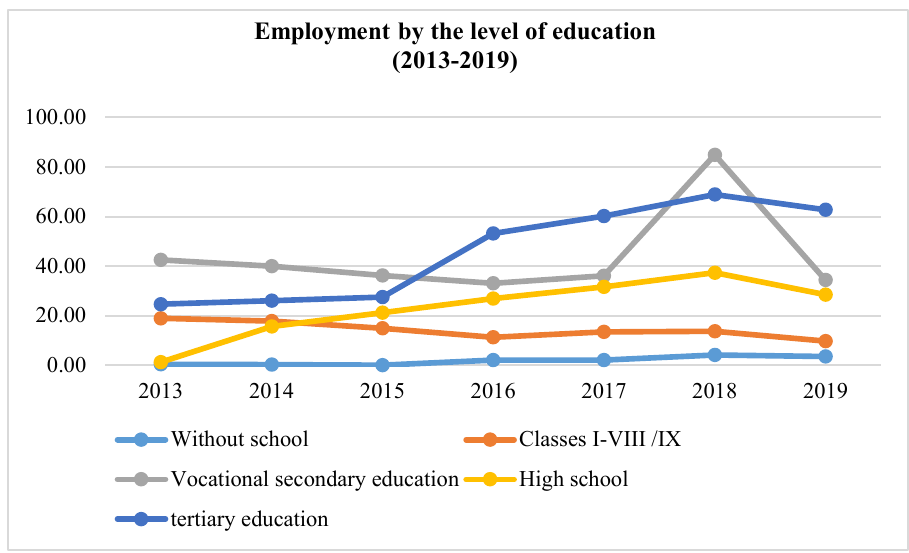
Fig. 3. The employment by the level of education in Kosovo (2013–2019). Source: Kosovo Agency of Statistics, the authors’